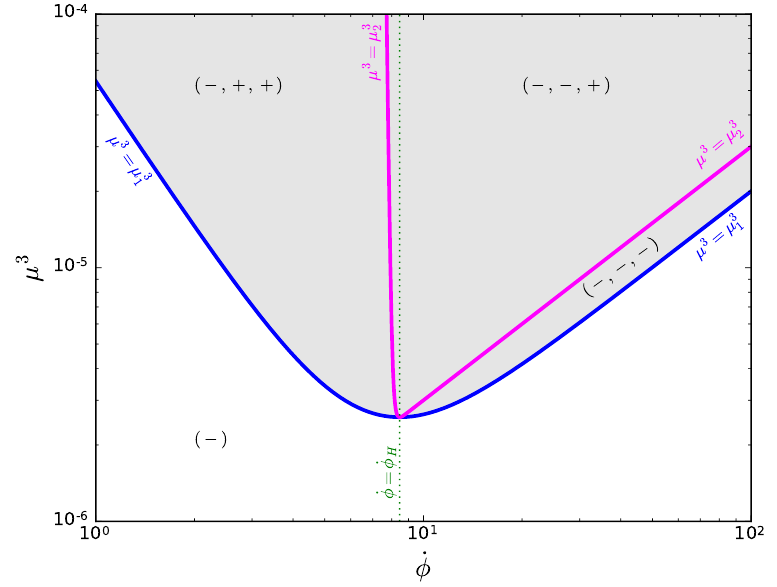
Figure 22 . (cid:22) 3 (the blue line) and (cid:22) 3 (the magenta line) are shown as a function of _ (cid:30) . Here we 1 2 take f = 10 3 and H = 10 (cid:0) 7 in the unit of (cid:3) b = 1. ( (cid:0) ), ( (cid:0) ; + ; +), ( (cid:0) ; (cid:0) ; +), and ( (cid:0) ; (cid:0) ; (cid:0) ) are same as (cid:12)gure 20. The gray region does not satisfy eq.